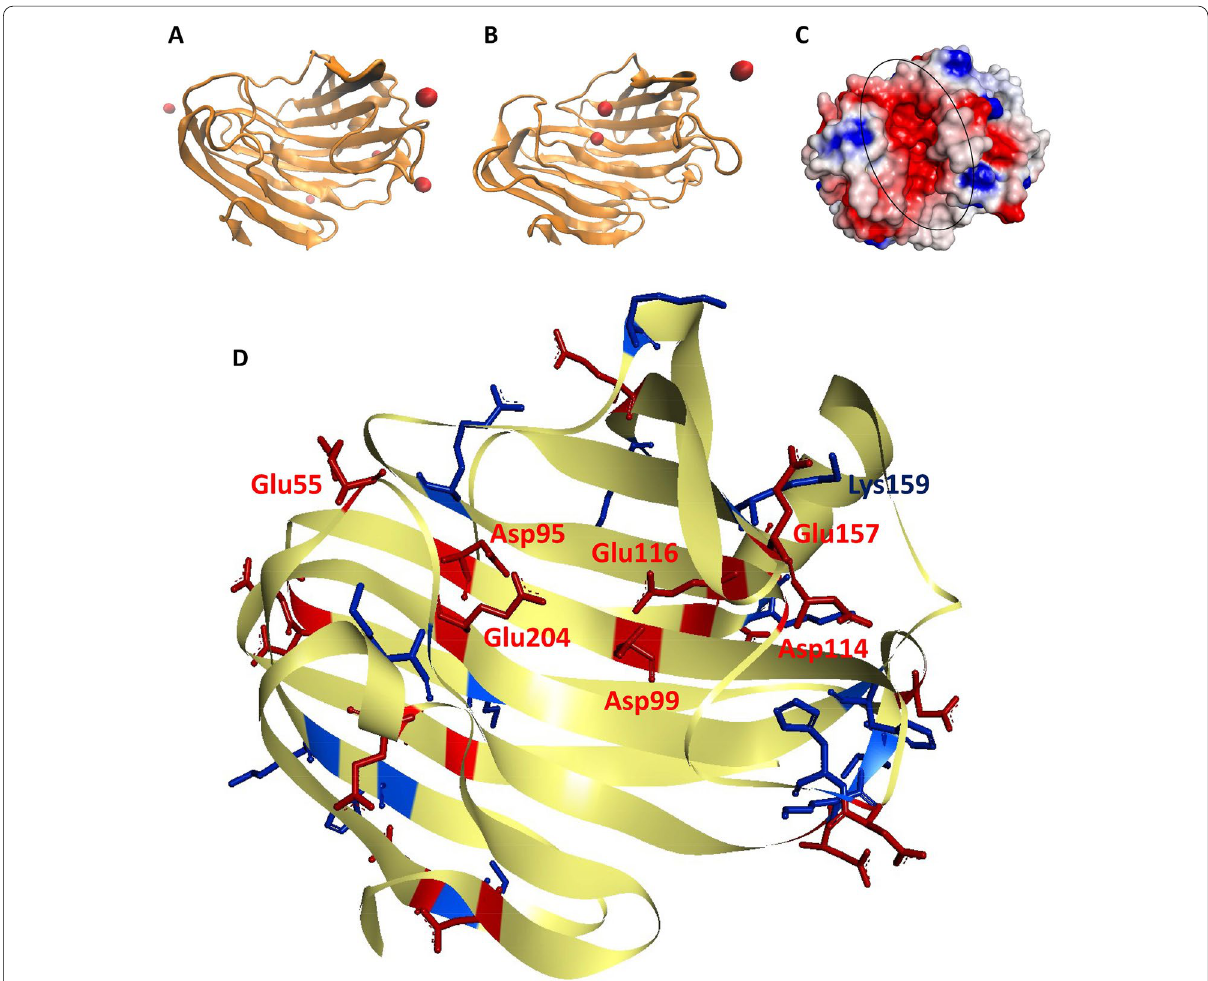
Fig. 5 The function of NaCl on salt tolerance and thermostability. A The spatial position of Na + before MD simulation at 300 K in the absence of NaCl. B The spatial position of Na + after 5 ns MD simulation at 300 K in the absence of NaCl. The red sphere represents Na + . C Surface electrostatic potential of An EGL. The region circled with the ellipse is the substrate binding pocket. Electrostatic potential between as colored gradient from red to white to blue. D Charged residues of An EGL. The electropositive and electronegative residues are colored with blue and red,